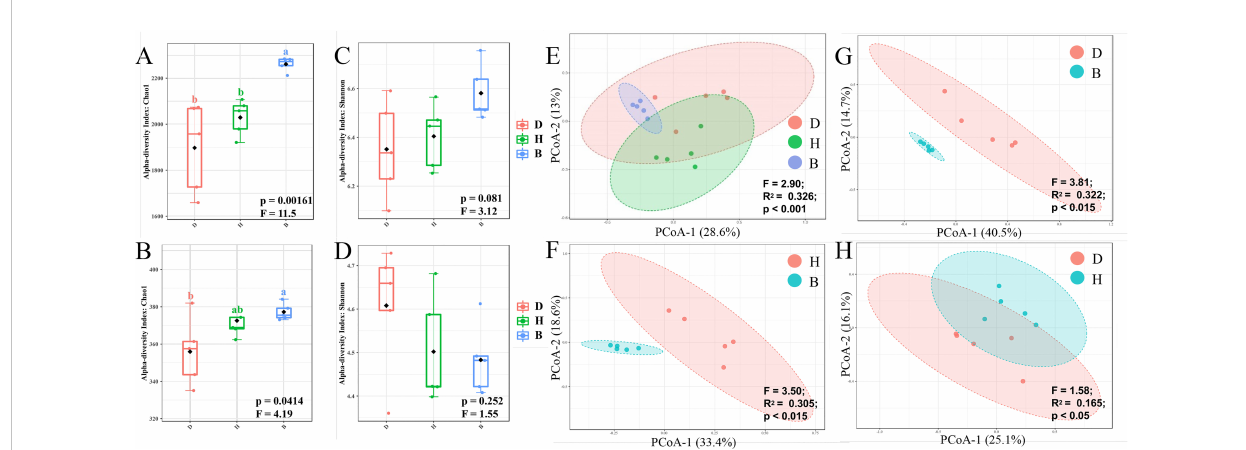
FIGURE 2 Diversity analyses of bacterial community in soil samples. Alpha diversity indicated by Chao1 (A) and Shannon (B) index of ASV level, and Chao1 (C) and Shannon (D) index of genus level was visualized by box plots. Among the estimated values ranging between 25% and 75%, of which the median was shown, the minimum and the maximum observed values within each dataset were listed. The p values across different groups were displayed at the bottom of each graph. Statistically signi fi cant differences (One-way ANOVA) were calculated between different soil samples. Lower letters represented statistical differences at the 95% con fi dence interval (p < 0.05). Beta diversity indicated by Bray-Curtis dissimilarity was visualized by PCoA method on ASV level across three different groups (E) , H and B (F) , D and B (G) , D and H (H) . Statistically signi fi cant differences (PERMANOVA) were calculated between different groups, F-value, R square and p-value were